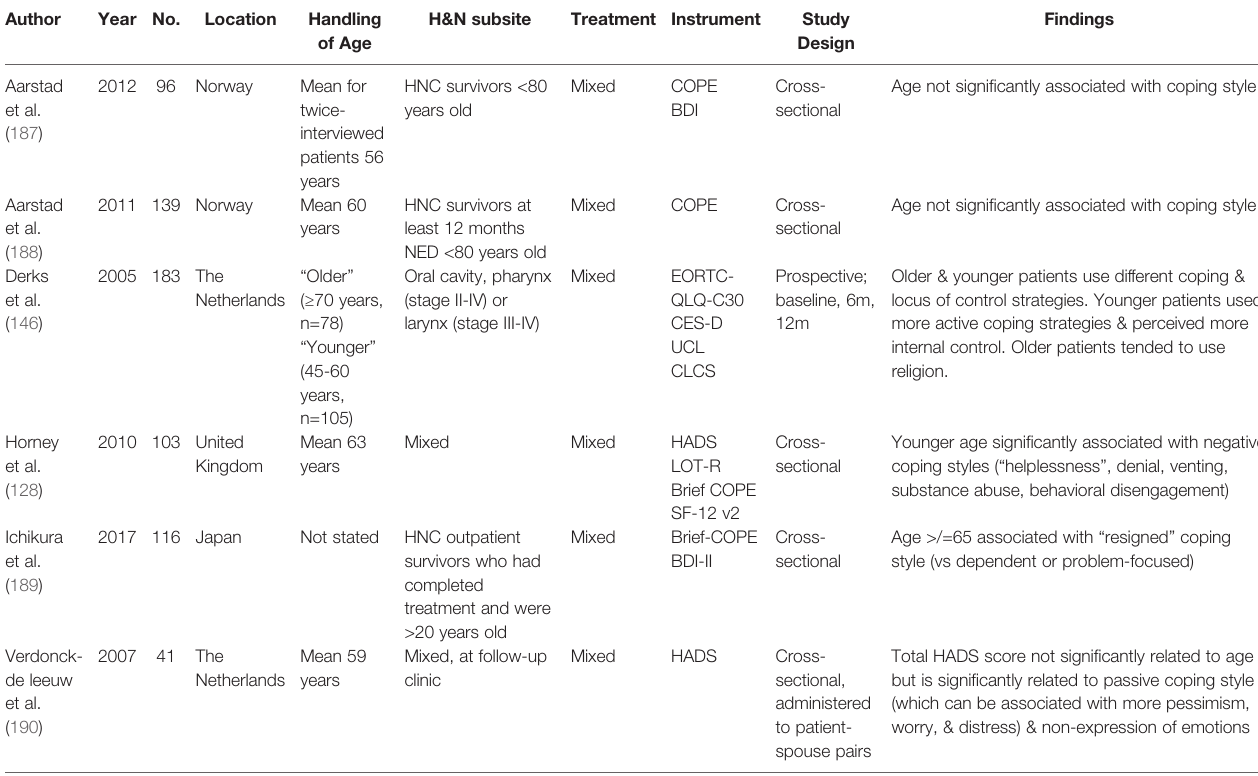
TABLE 11 | Studies reporting on coping